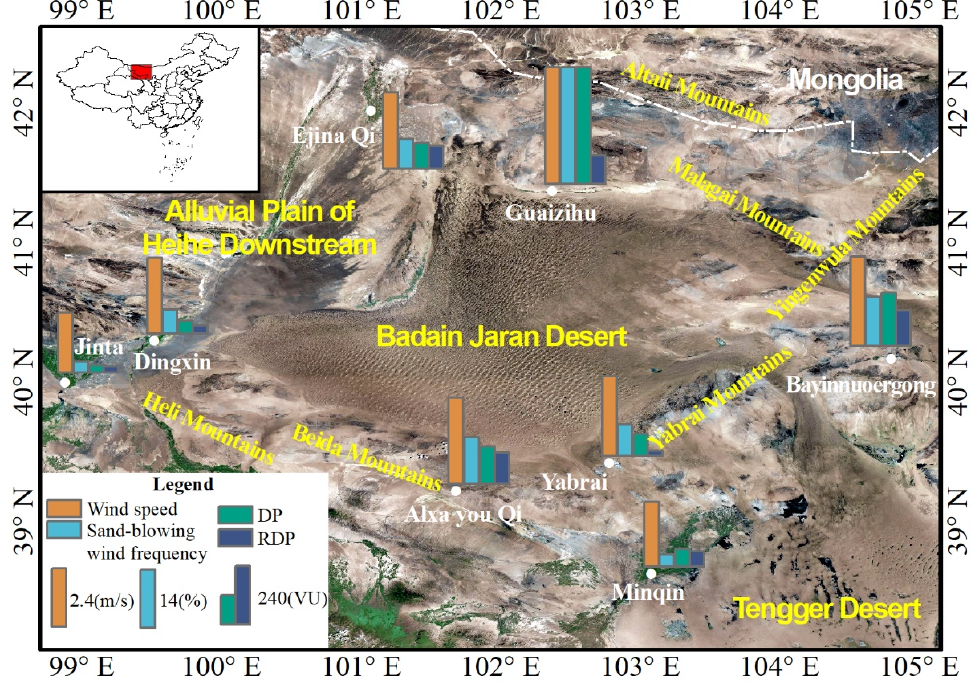
Figure 1. The location of the Badain Jaran Desert (BJD) and wind regime in the BJD. The yellow, blue, green and purple bars represent wind speed, sand-blowing wind frequency, DP and RDP, respectively.